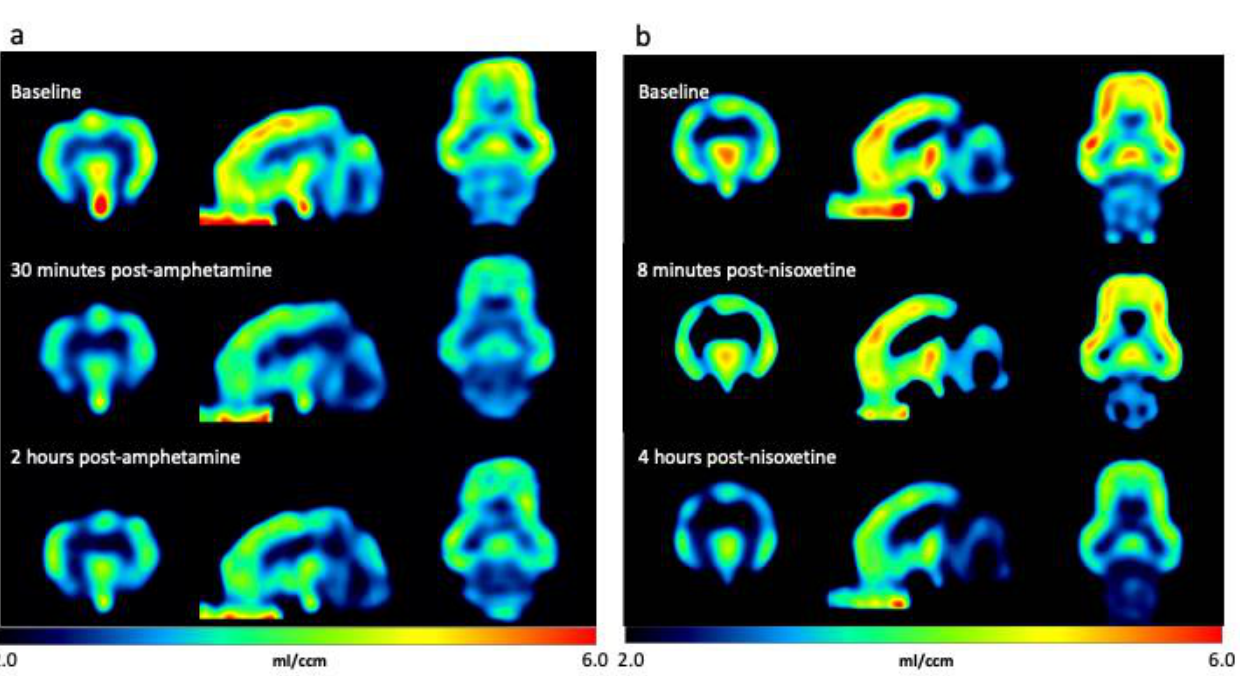
Figure 3. Representative voxel-wise [ 11 C]yohimbine volume of distribution parametric maps in minipig brain at baseline and after drug challenges. Data are presented for scans before and after challenges with ( a ) 1 mg/kg amphetamine (baseline (top), 30 min post-challenge (middle) and 2 h post-challenge (bottom)) and ( b ) 1 mg/kg nisoxetine at baseline (top), 8 min post-challenge (middle) and 4 h post-challenge (bottom). Data are shown in coronal (left), sagittal (middle) and axial (right) views. Note that the areas of highest binding at baseline are found in the thalamus, cortex and brain- stem, and binding is displaced at different times during the two challenges.